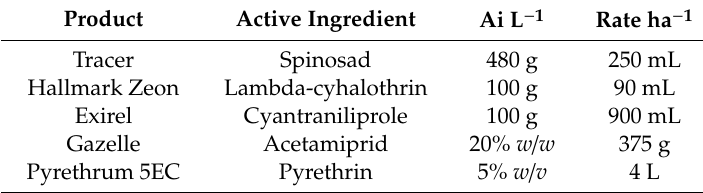
Table 3. Products and rates of plant protection products used in the cherry leaf bioassay in 2017.